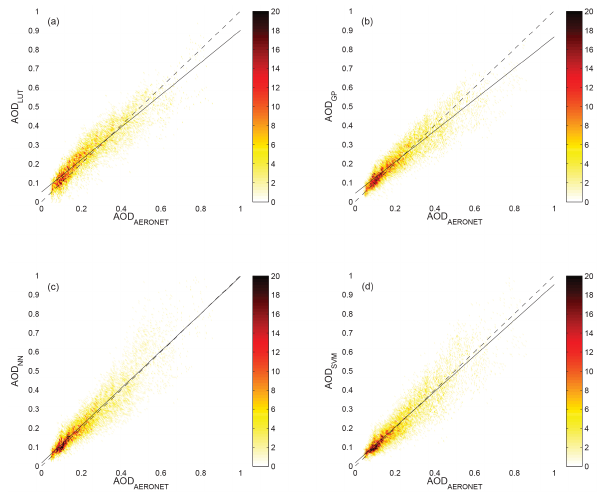
Figure 1. Observed (AERONET) and predicted AOD using the methods of (a) LUT (look-up table), (b) GP (Gaussian process), (c) NN (neural network) and (d) SVM (support vector machine). The colourbar indicates the absolute number of results in the ar- eas with the interval of 0.01 × 0.01. The 1:1 lines and linear fits included. The number of observations is 10684. The rela- tion for the linear fits is estimated AOD = a 1 + a 2 × AERONET AOD, and the coefficients of the least square fits with their er- rors are ( a 1, a 2): 0.050( ± 0.001), 0.849( ± 0.004); 0.043( ± 0.001), 0.820( ± 0.003); 0.016( ± 0.001), 0.979( ± 0.004) and 0.018( ± 0.001), 0.936( ± 0.004), for LUT, GP, NN and SVM